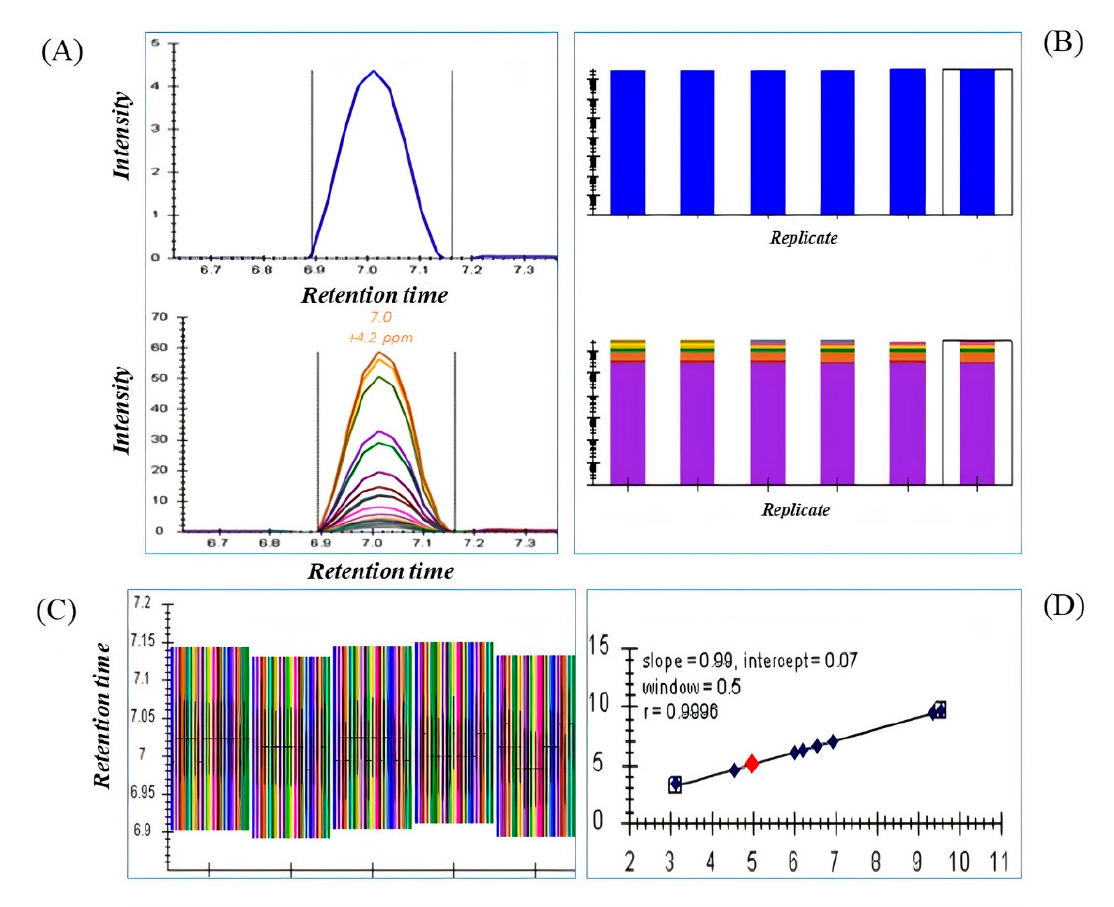
Figure 2. ( A ) Extracted precursor ion chromatogram [top] and fragment ion chromatogram [bottom] of a drug standard dipyridamole (as an example). ( B ). Comparison of peak areas of the precursor [top] and fragment [bottom] ions in multiple samples and replicates. ( C ) The retention time view provides information of each precursor and its fragments present in each serum replicate. ( D ) The calibration curve in the figure proved the consistency and reproducibility of 10 standard drugs in each replicate over the retention time. Table 1. Pharmaceutical drug quantification results by comparing LOD/LOQ for MS1 full-scan,